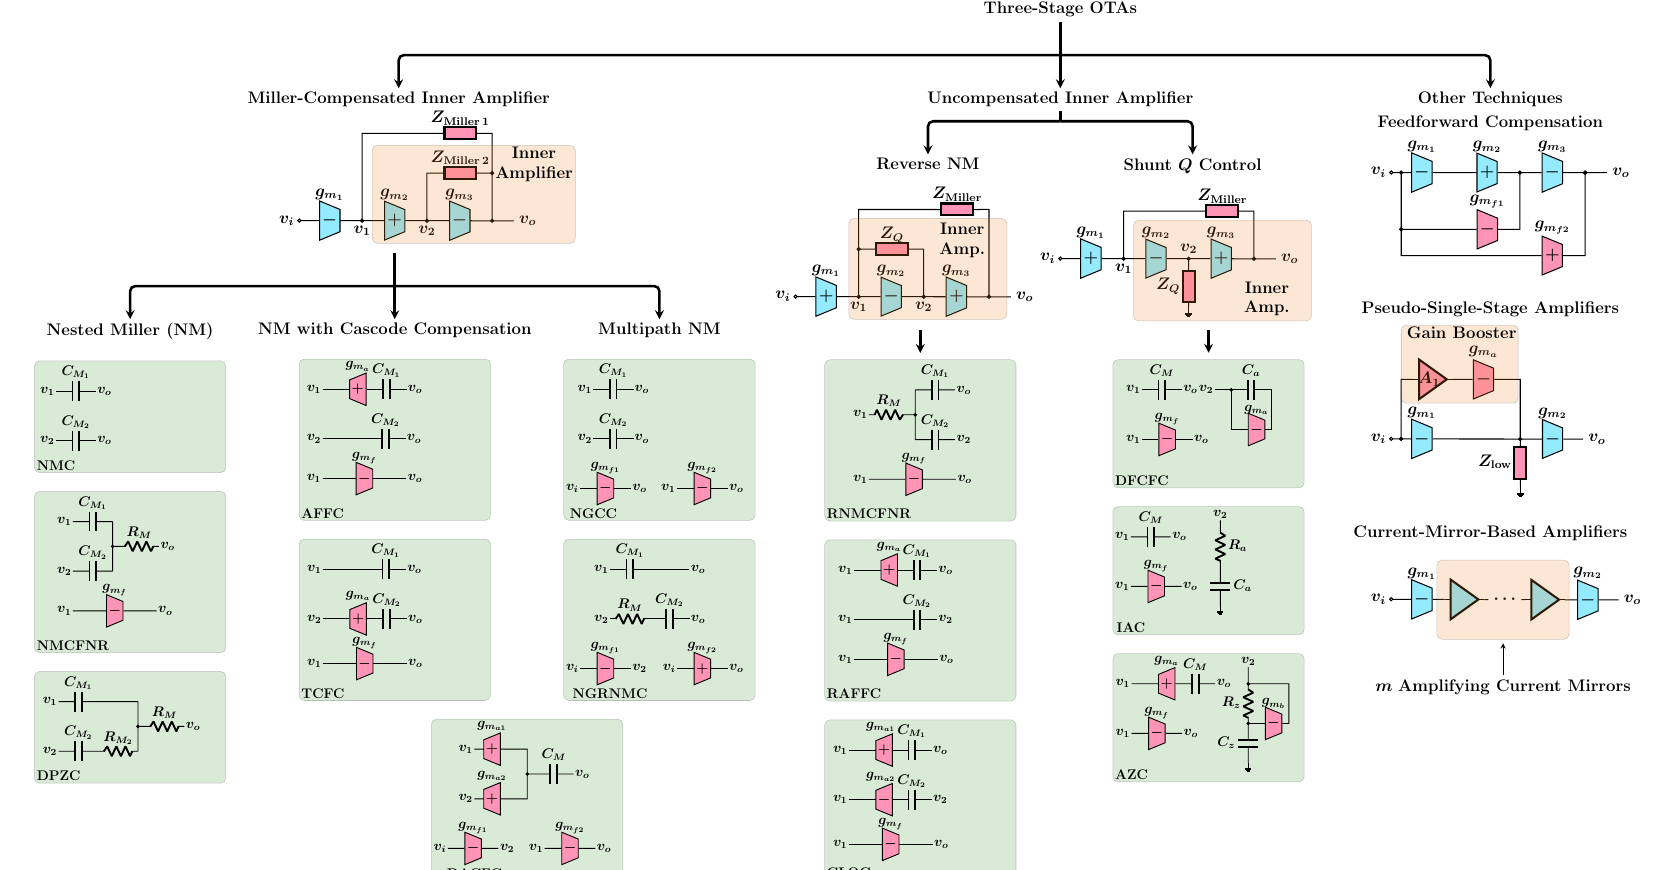
Figure 9. Classificationof three-stage OTA compensation techniques with example architectures given for each category. Cyan blocks indicate parts of the core amplifier while magenta blocks indicate components used for